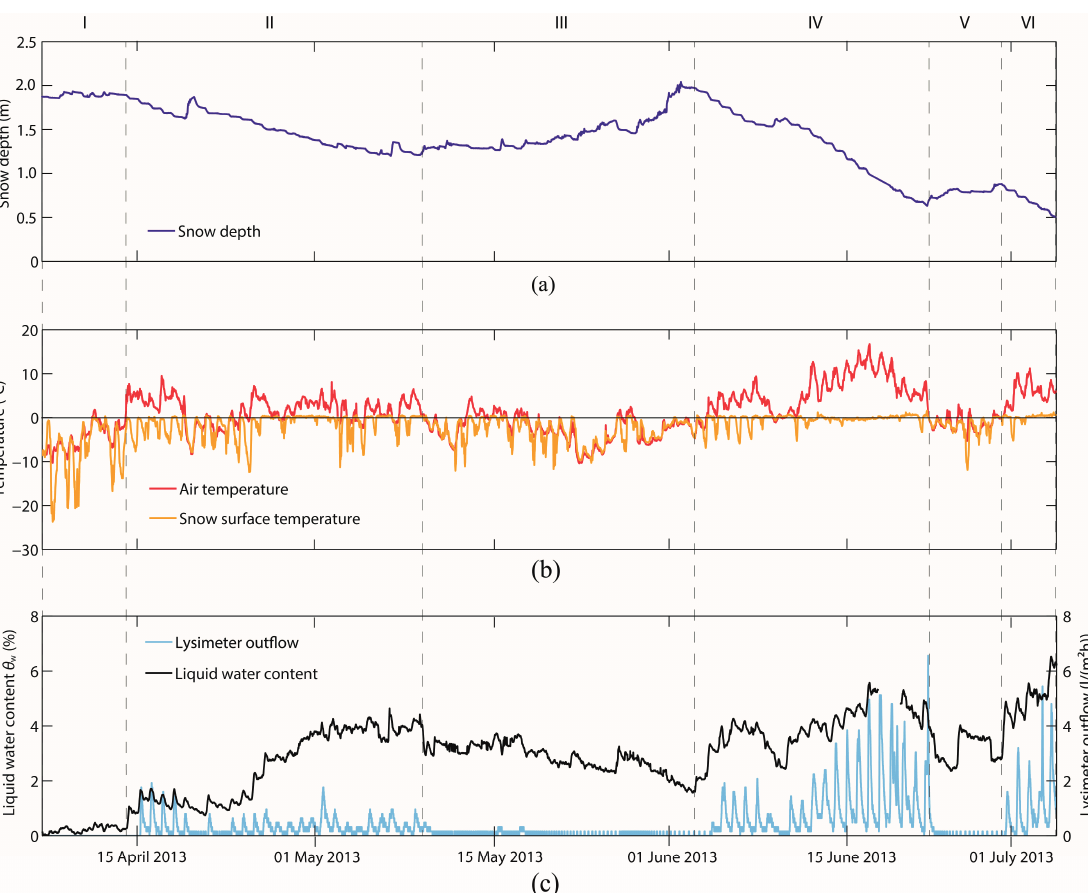
Figure 8. ( a ) Snow depth; ( b ) air and snow surface temperature and ( c ) lysimeter